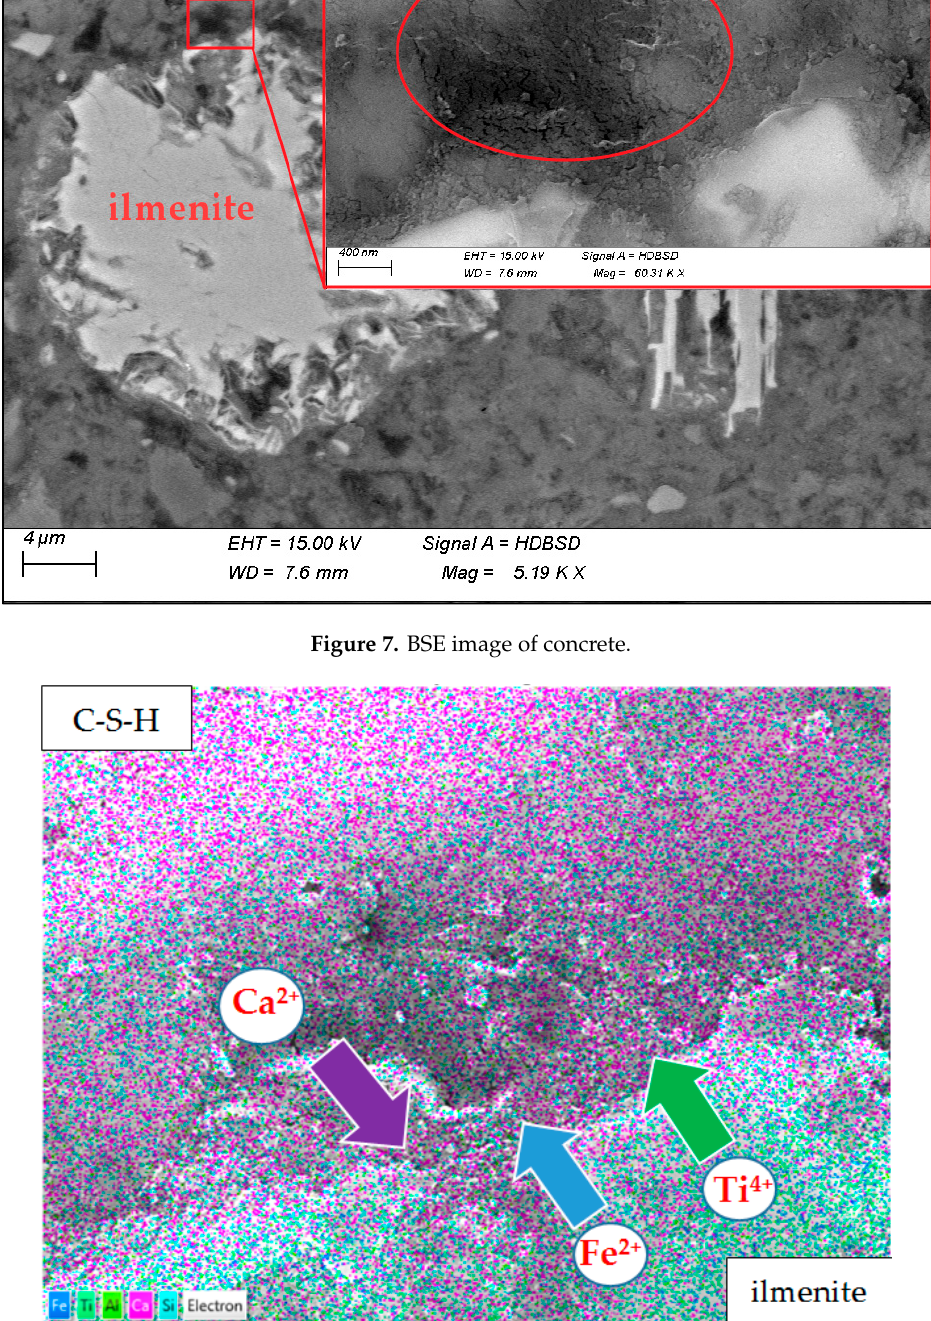
Figure 8. Migration of ions between the C-S-H phase and ilmenite.